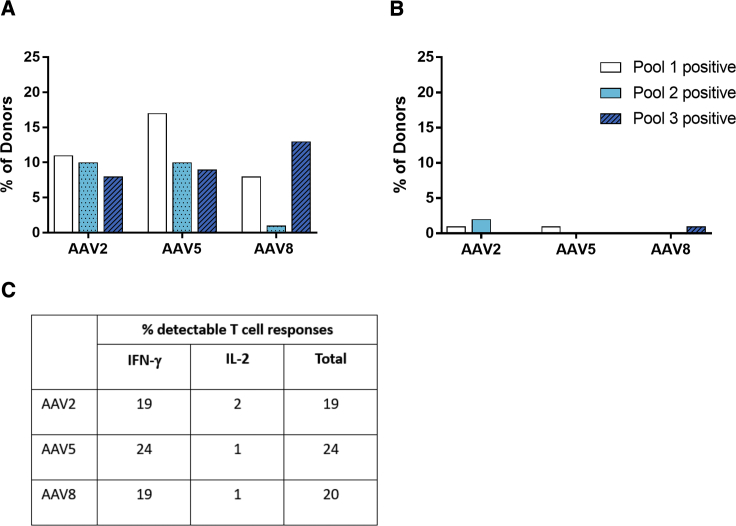
Prevalence of T Cell Responses against Different AAV SerotypesFrequency of capsid-specific (A) IFN-γ- or (B) IL-2-secreting T cells detected using ELISpot analysis in PBMCs from 90 healthy donors. PBMCs were stimulated with AAV8, AAV5, or AAV2 peptide pools for 18 to 24 h. The percentage of donors positive for each peptide pool is depicted, showing a similar prevalence for all serotypes. (C) Table showing percentage of donors with detectable IFN-γ and IL-2 T cell responses against AAV2, AAV5, and AAV8.